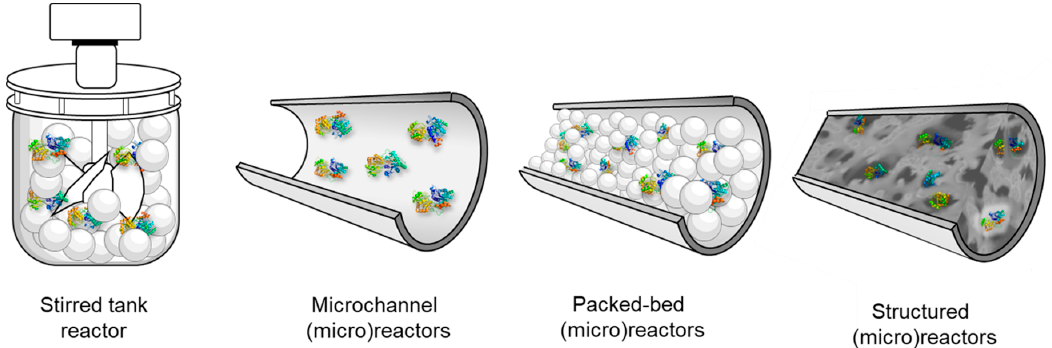
Figure 15. Different reactor types for the immobilization of Leloir